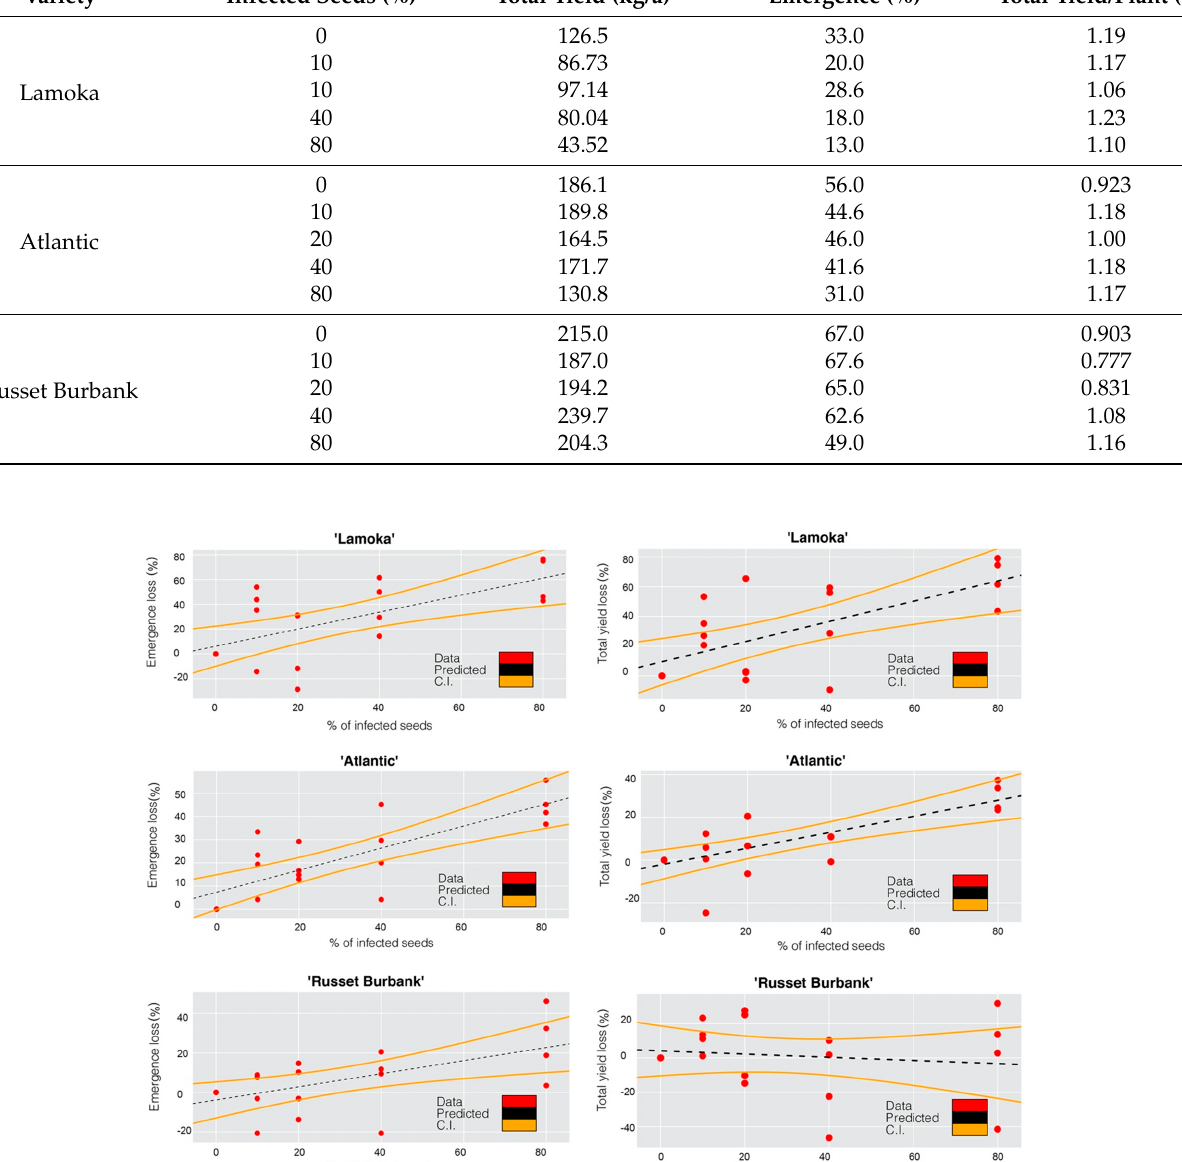
Table 3. Effects of infection level of seed pieces with Dickeya dianthicola on yield and emergence of potato in 2020. Variety